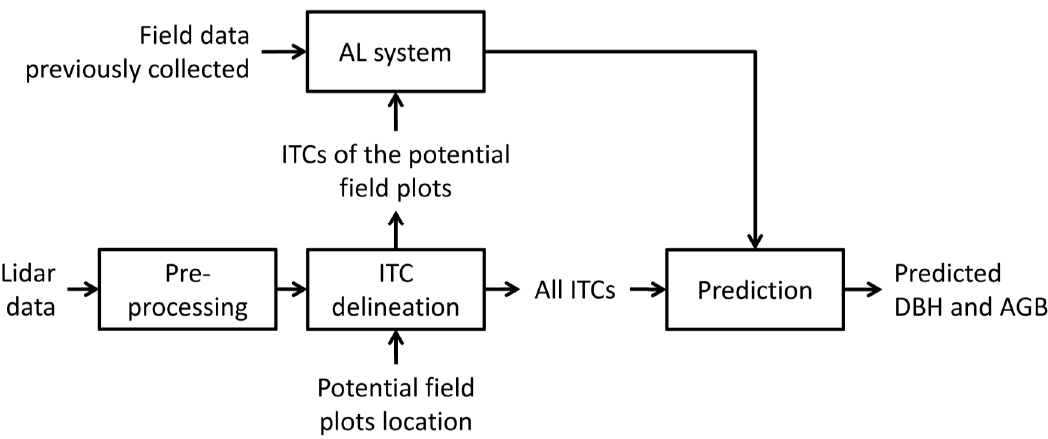
Figure 2. Processing steps adopted in this study.